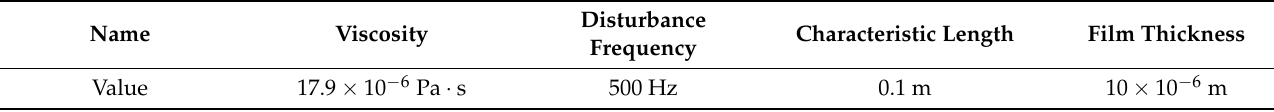
Figure 5. Dynamic stiffness modulus of the 1D parallel slider. Table 1. Parameters of a typical aerostatic